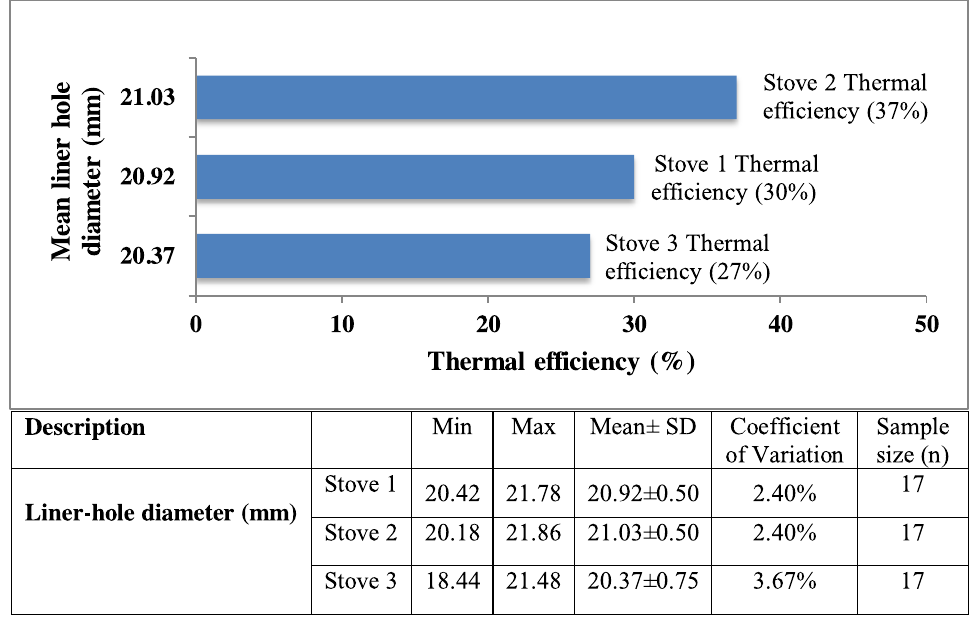
Fig. 6. Liner-hole diameter and thermal ef fi